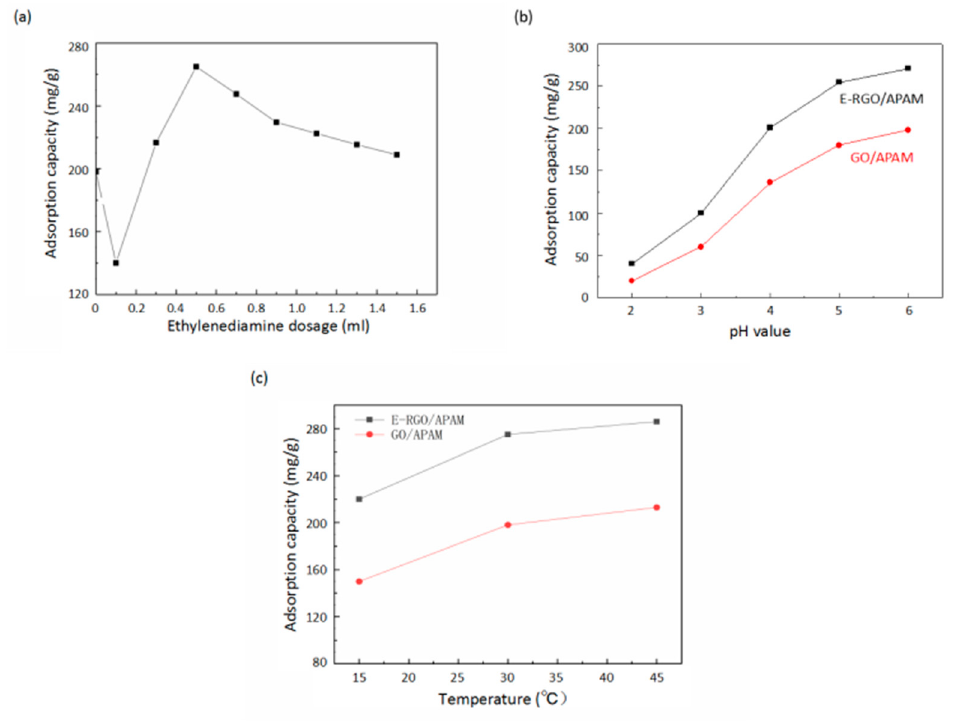
Figure 4. ( a ) Effect of ethylenediamine dosage on adsorption capacity of E-RGO/APAM; ( b ) effect of pH value on adsorption capacity of GO/APAM and E-RGO/APAM; ( c ) effect of temperature on adsorption capacity of GO/APAM and